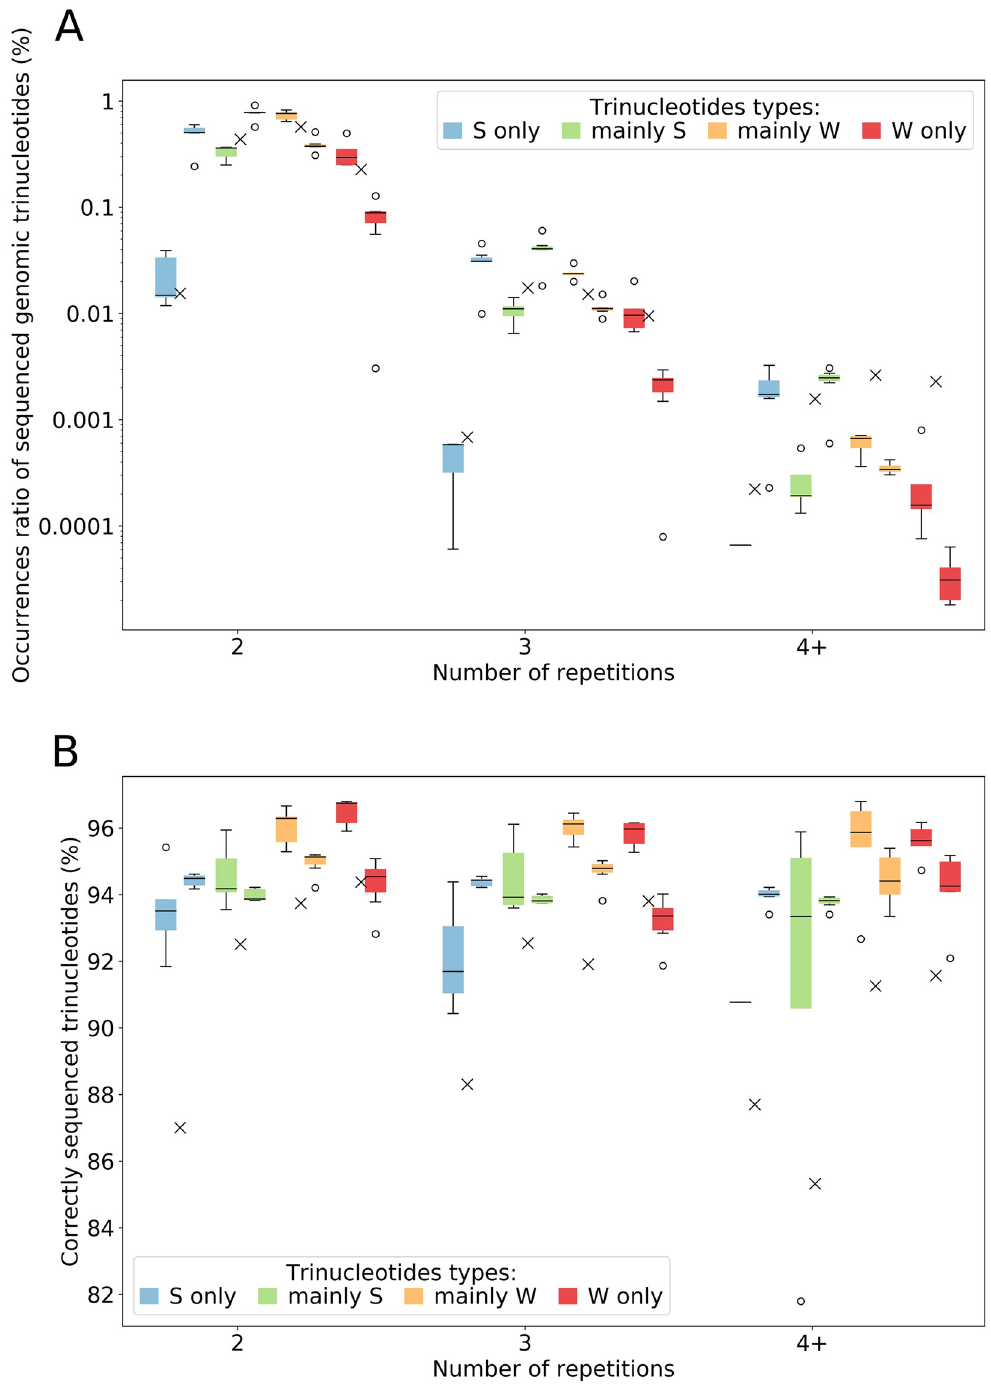
Fig 12. Sequenced genomic trinucleotide repeats’ occurrences and accuracy. Trinucleotides with at least 4 repetitions are gathered within “4+” label. Global results are presented with boxplots for bacterial species (left boxplot for low-GC bacteria, and right one for high-GC) and crosses for human data (representing the mean of both datasets). For each bacterial species, only results for at least 100 occurrences are kept. Each color represents a trinucleotide category: blue for S -only, green for mostly- S , orange for mostly- W , and red for W -only trinucleotides. Results were computed on all reads for bacterial data, and on a subset of 100,000 reads for human data.